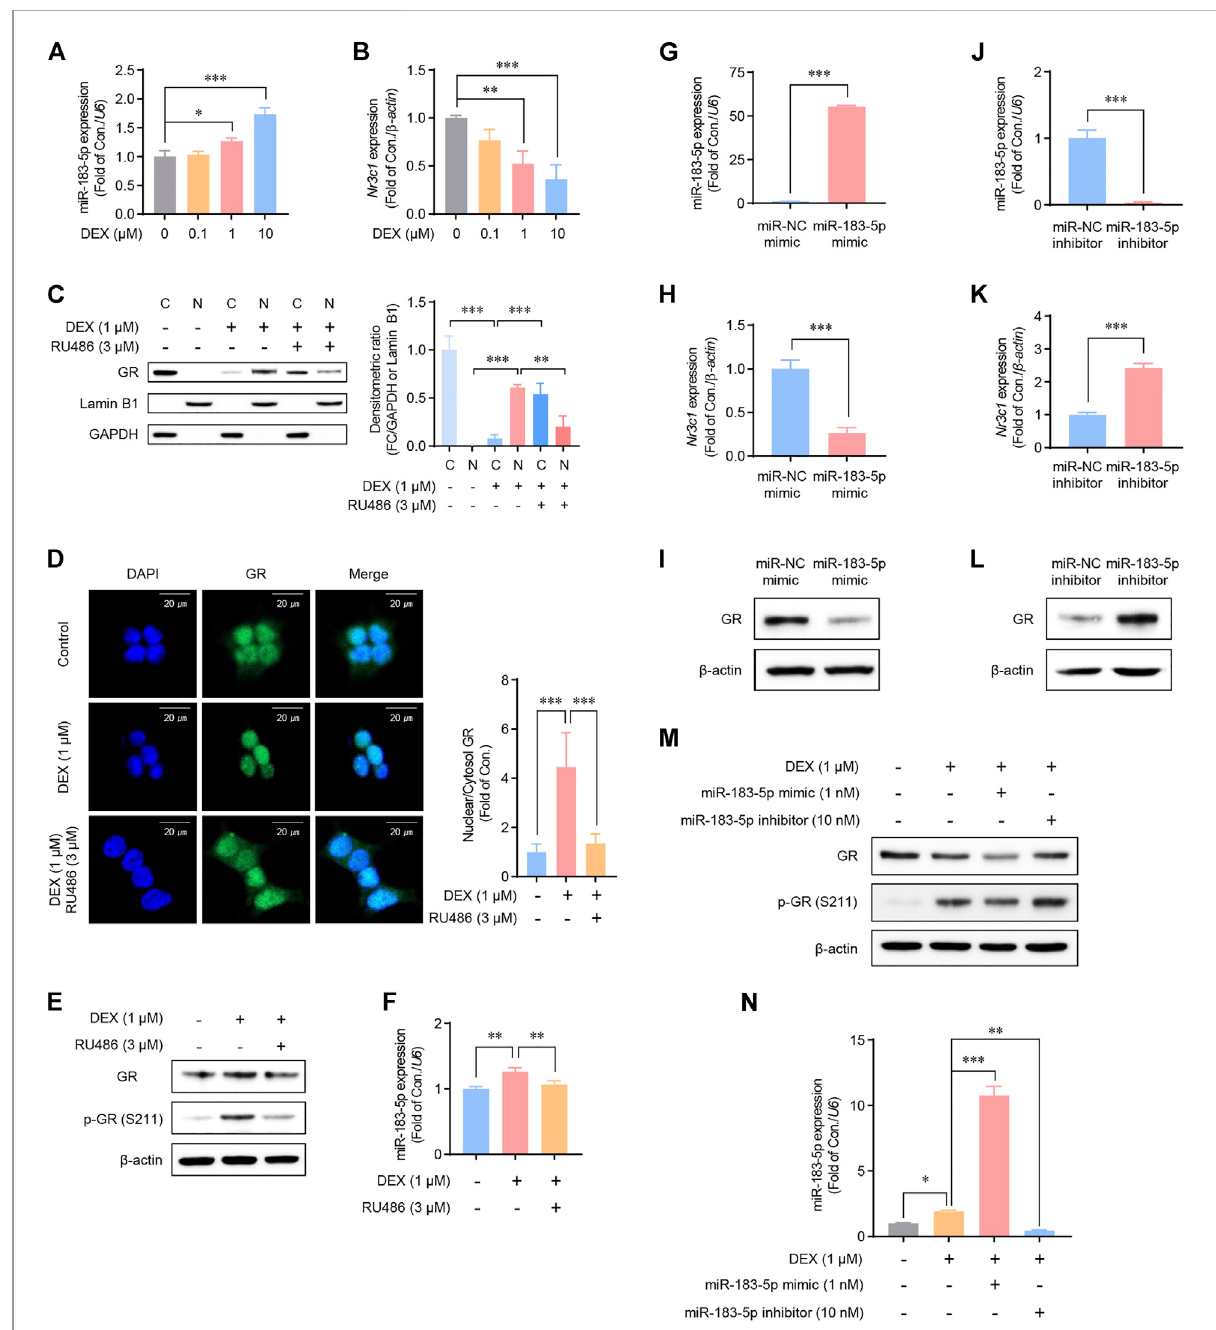
FIGURE 3 Regulation of glucocorticoid receptor (GR) and miR-183-5p expression in HEK293 cells. (A,B) Cells were treated with DEX as indicated. MiR- 183-5pand Nr3c1 expressionlevelwasanalyzedandnormalizedto U6 and β -actin level.Dataarepresentedasthefoldchangerelativetothecontrol group. Statistical analyses were performed using the one-way ANOVA. Error bars represent mean ± SD ( n = 3). * p < 0.05, *** p < 0.001. (C) Western blotsshowingthenucleartranslocationofGRproteinfollowingDEXtreatment.GAPDHandLaminB1wereusedasthecytoplasmicandnuclear loadingcontrols,respectively.Quanti fi cationoftherelativeblotintensityoftheGRproteinwasperformedusingImageJsoftware.Statisticalanalyses were performed using the one-way ANOVA. Error bars represent mean ± SD ( n = 3). ** p < 0.01, *** p < 0.001. (D) Cells seeded on sterile coverslips were treated with DEX for 6 h, then fi xed with methanol, incubated with fl uorescently tagged mouse monoclonal GR antibody, and stained with AlexaFlour488(green)-labeledanti-mouseantiseraandDAPI.GRsignalswerethenvisualizedbyconfocalmicroscopy.Quanti fi cationoftherelative fl uorescence intensity of GR was performed using ImageJ software. Data are presented as the fold change relative to the control group. Statistical analyses were performed using the one-way ANOVA. Error bars represent mean ± SD ( n = 3 – 6). ** p < 0.01. (E) Cells were treated with 1 μ M of DEX and 3 μ M of RU486 as indicated for 24 h. (F) Cells were treated with DEX and RU486 as indicated. MiR-183-5p expression level was analyzed and